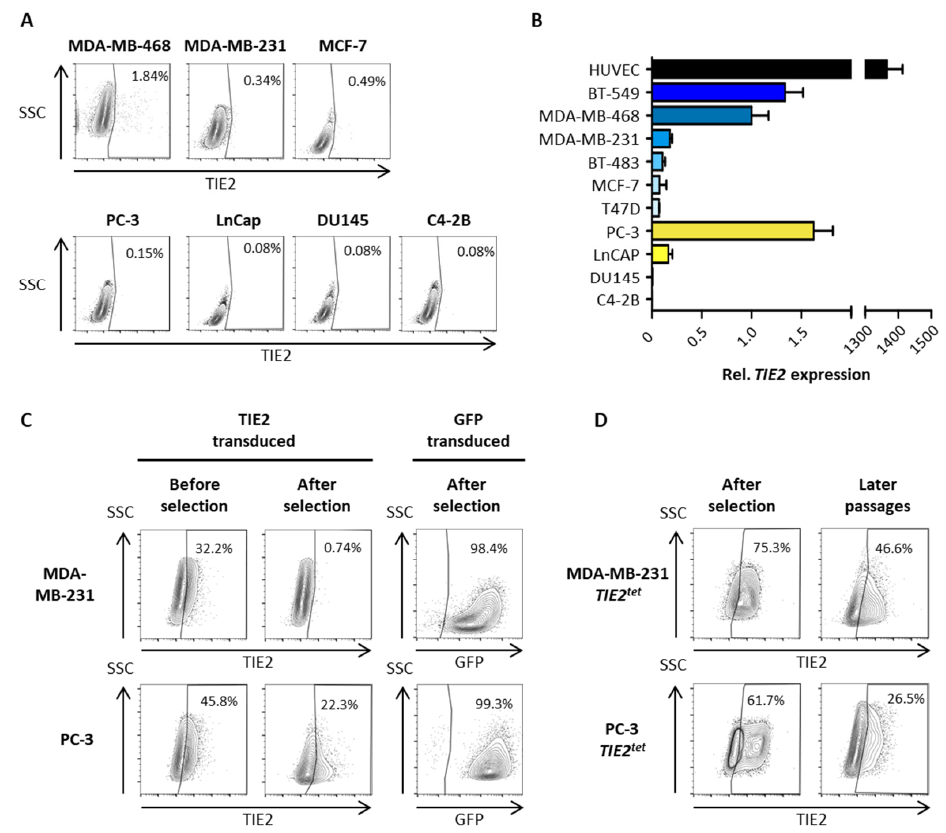
Figure 3. TIE2 expression is low in cancer cell lines in culture. ( A ) Evaluation of TIE2 protein expression in breast cancer (BCa) and prostate cancer (PCa) cell lines using flow cytometry. ( B ) Evaluation of TIE2 mRNA expression using RT-qPCR. ( C ) MDA-MB-231 and PC-3 cells were transduced with lentiviral particles to over-express TIE2 or GFP. Expression was measured by flow cytometry five days after transduction (before selection) and three weeks after transduction (after selection). ( D ) MDA-MB-231 and PC-3 cells were transduced to express TIE2 using a Tet-On inducible system. Transduced cells were selected with puromycin, and TIE2 expression was measured by flow cytometry (after selection). MDA-MB-231 cells were then cultured for three weeks, and PC-3 cells were cultured for one week, and TIE2 expression was measured again (later passages). Flow cytometry results are represented as contour plots overlaid with outliers. Values indicate the percentage of TIE2 + cells. TIE2 mRNA expression is represented as the average ± SEM vs. MDA-MB-468